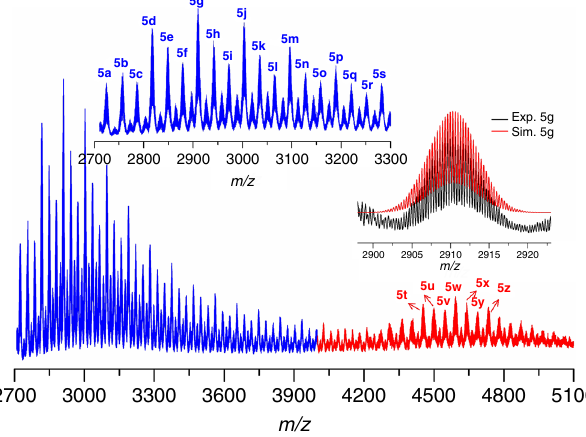
Fig. 7 Positive-ion ESI-MS of SD/Ag11 dissolved in acetonitrile. Insets: The enlarged MS of triply-charged species (blue line) and comparison of the experimental (black spectrum) and simulated (superimposed red spectrum) isotopic envelopes for 5g